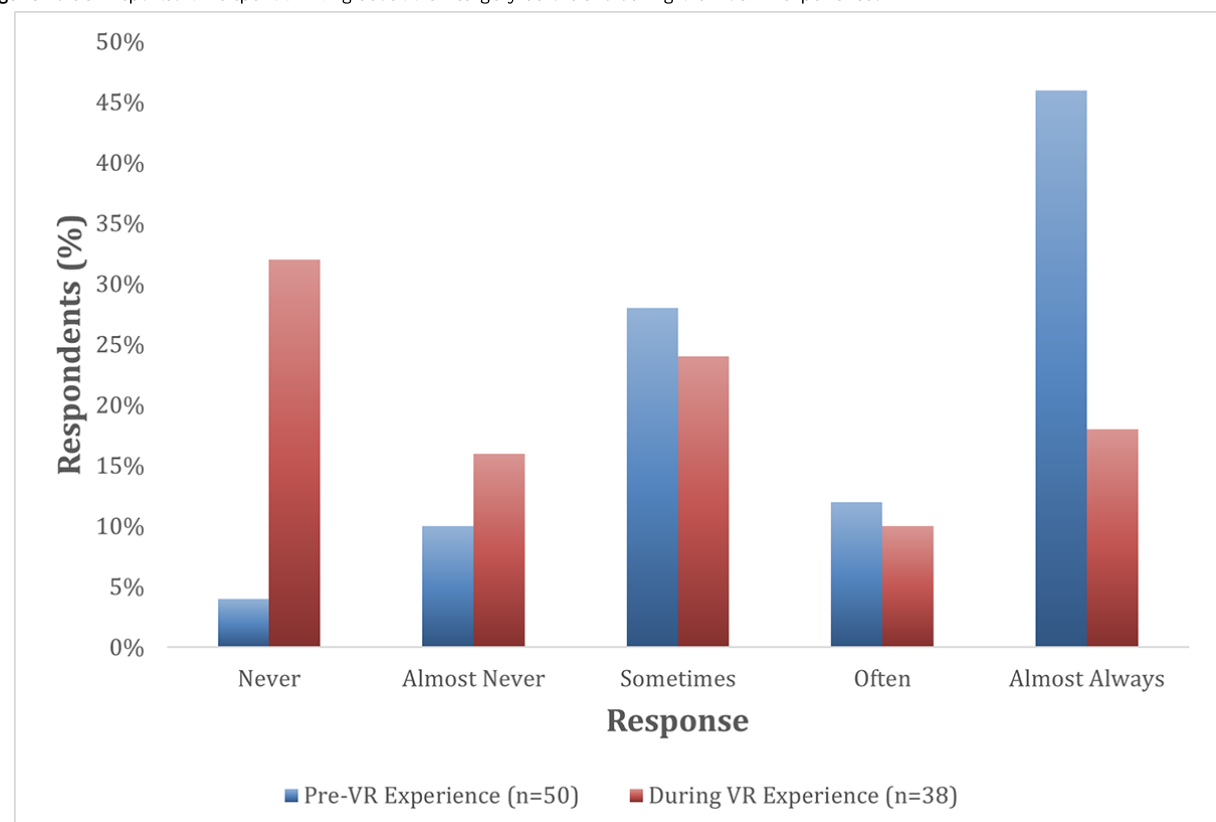
Figure 4. Self-reported time spent thinking about their surgery before and during the DocVR